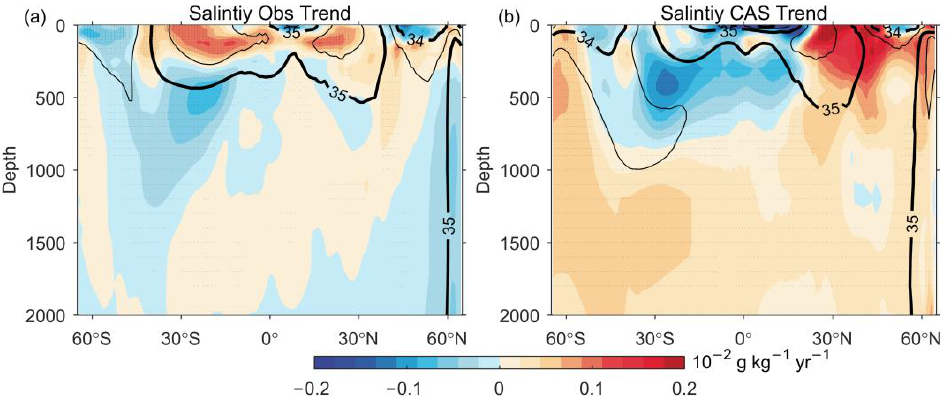
Figure 6. Linear trends of the globally zonal-mean salinity anomalies during 1960-2020: ( a ) for the ensemble means of the four observational products, ( b ) for CAS-ESM2-0 model. The unit of salinity is g kg −1 per year. The anomalies are relative to the 1990 – 2010 baseline. The stippling indicates the regions with statically significant signals (95% confidence level).